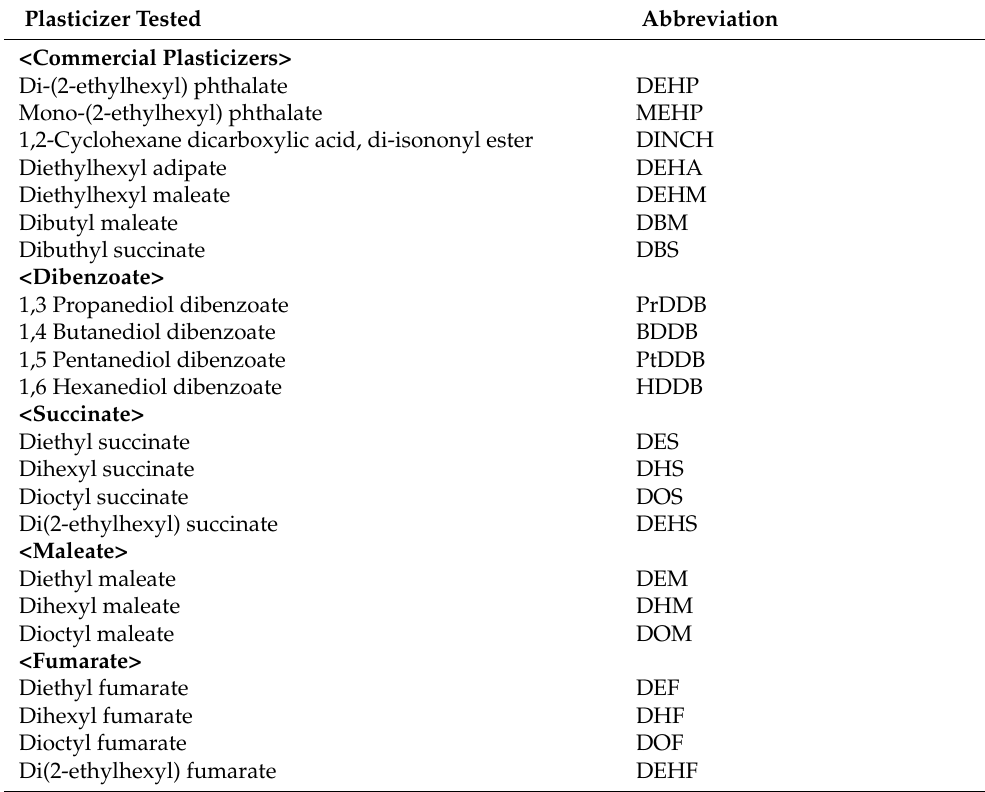
Table 1. A list of compounds tested in this